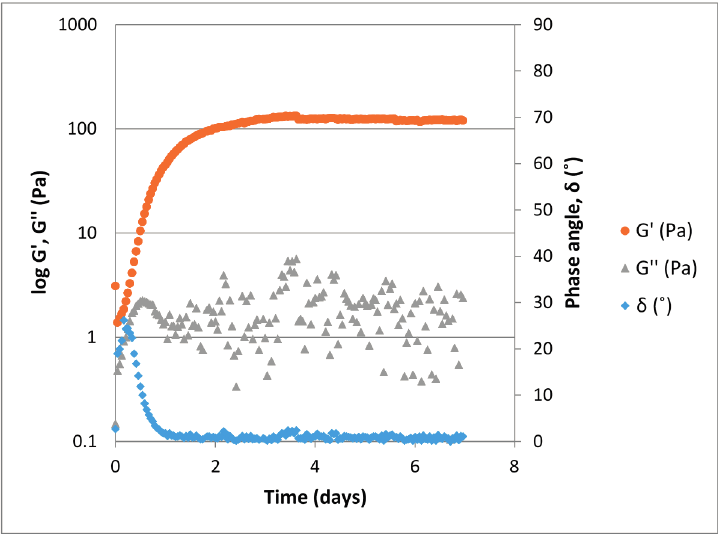
Figure 4. Typical gelling curve for a ViscoGel™, 1.0% ( w / w ) V2D2 at a 3% theoretical crosslinking (DES relative to primary amino groups) obtained through small strain oscillatory measurement (strain 1 × 10 − 3 , frequency 1 Hz, 1 mm gap, 40 mm plate-plate